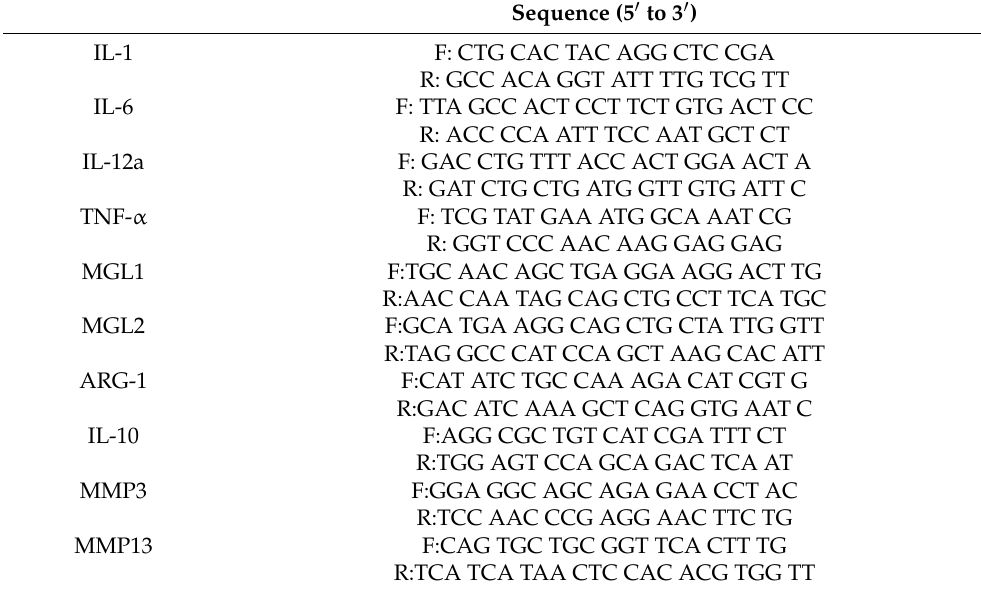
Table 1. Primer sequences used in